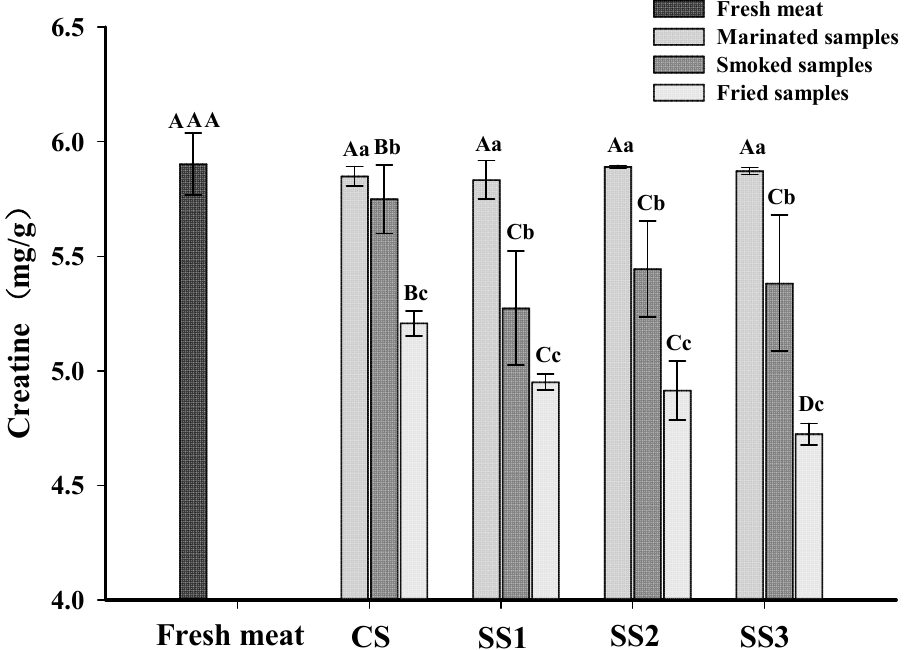
Figure 2. Influence of the partial replacements of NaCl by KCl on the creatine contents of bacon at different processing stages. A–D The differences between the creatine content in bacon at the same processing stage with different KCl-substituting rates and the content of creatine in fresh meat ( p < 0.05). a–c The differences of the creatine content in bacon at the same processing stage ( p < 0.05). CS, control (100% NaCl); SS1, 90% NaCl + 10% KCl; SS2, 80% NaCl + 20% KCl; and SS3, 70% NaCl + 30% KCl.